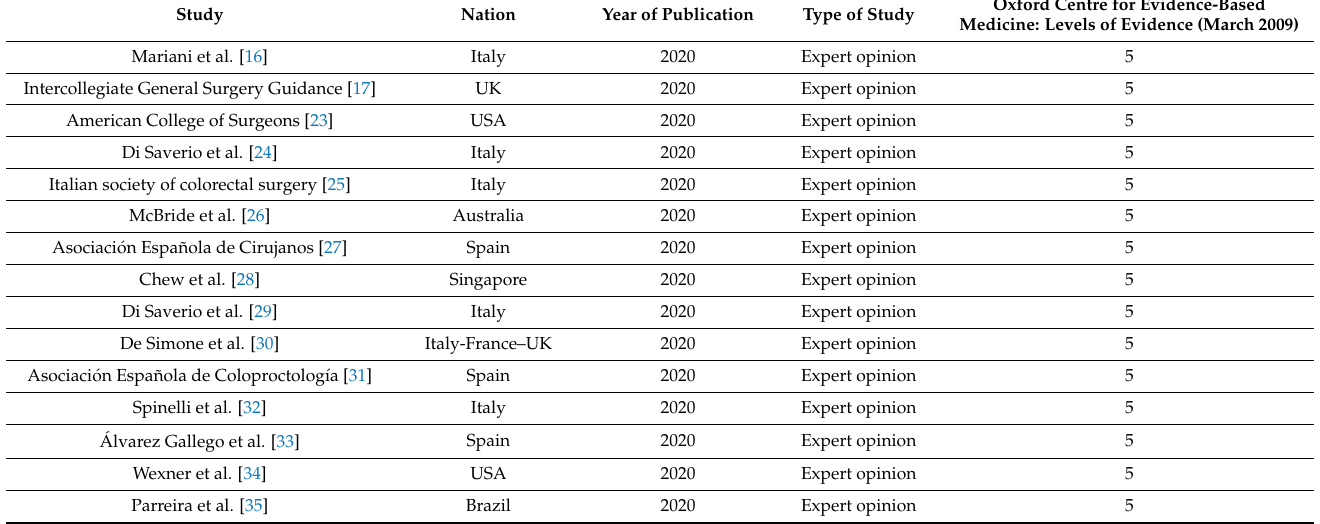
Table 1. Included studies—Expert